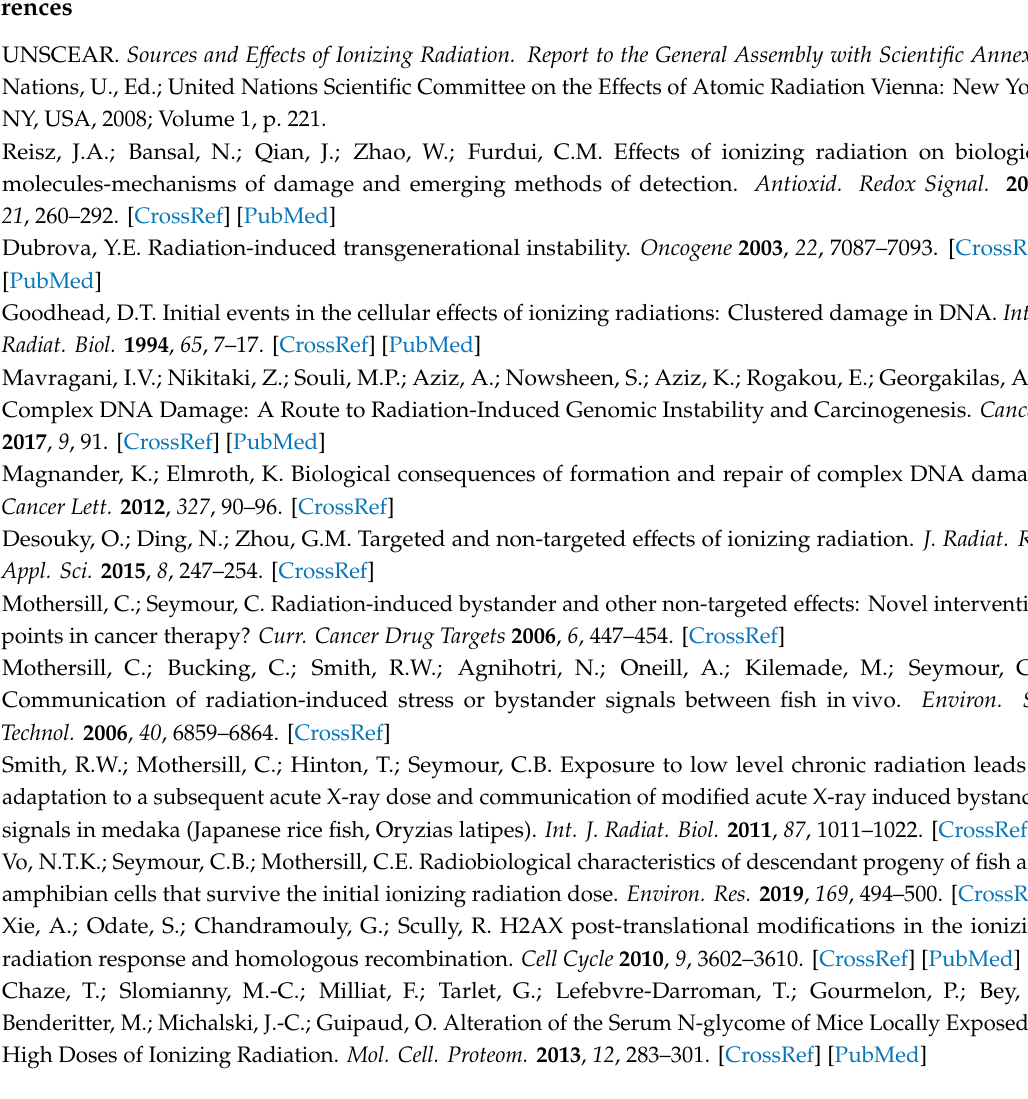
Table S1: Proteins identified in Carcasses in control and treated samples. Table S2: Proteins identified in Intestines in control and treated samples. Table S3: Proteins identified in Organs in control and treated samples. Table S4. Proteins with a ≥ 2 Fold change identified in Carcasses. Table S5 Proteins with a ≥ 2 Fold change identified in Intestines. Table S6. Proteins with a ≥ 2 Fold change identified in Carcasses. File S1: Animal Care and Use at